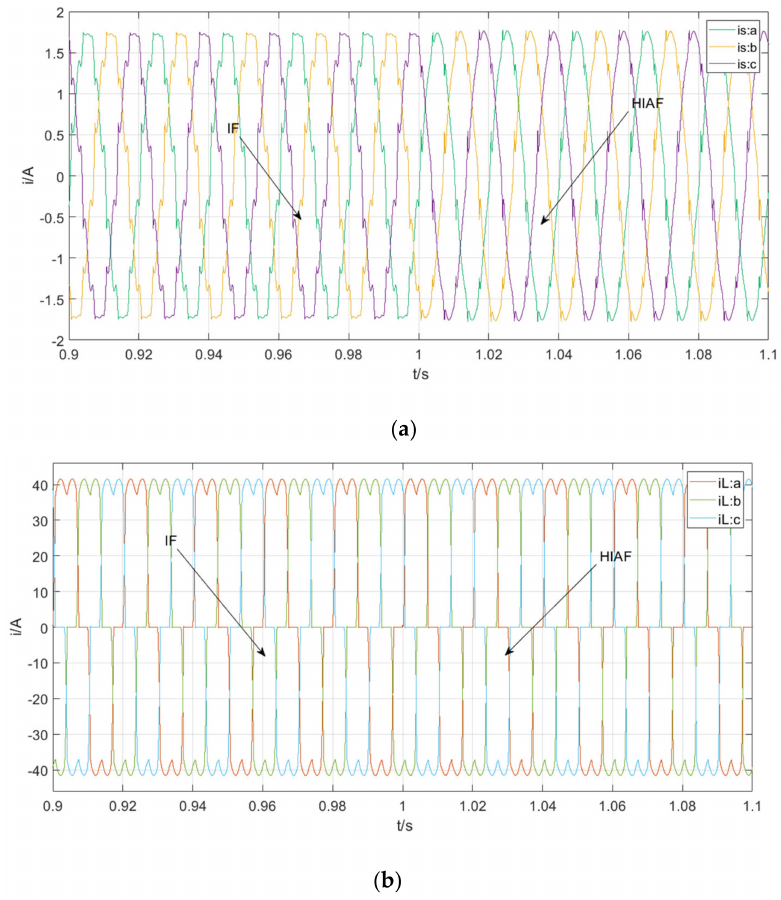
Figure 9. Dynamic response of the grid-side and load-side currents in the HIAF system. ( a ) Dynamic responses of the three-phase grid-side currents i s ( b ) Dynamic responses of the three-phase load-side currents i L 2